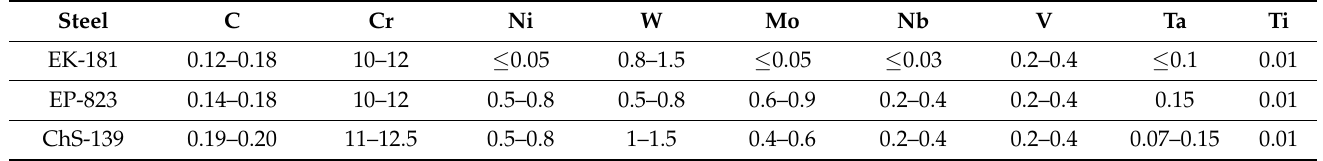
Table 1. Chemical content of experimental steels, mass % *.